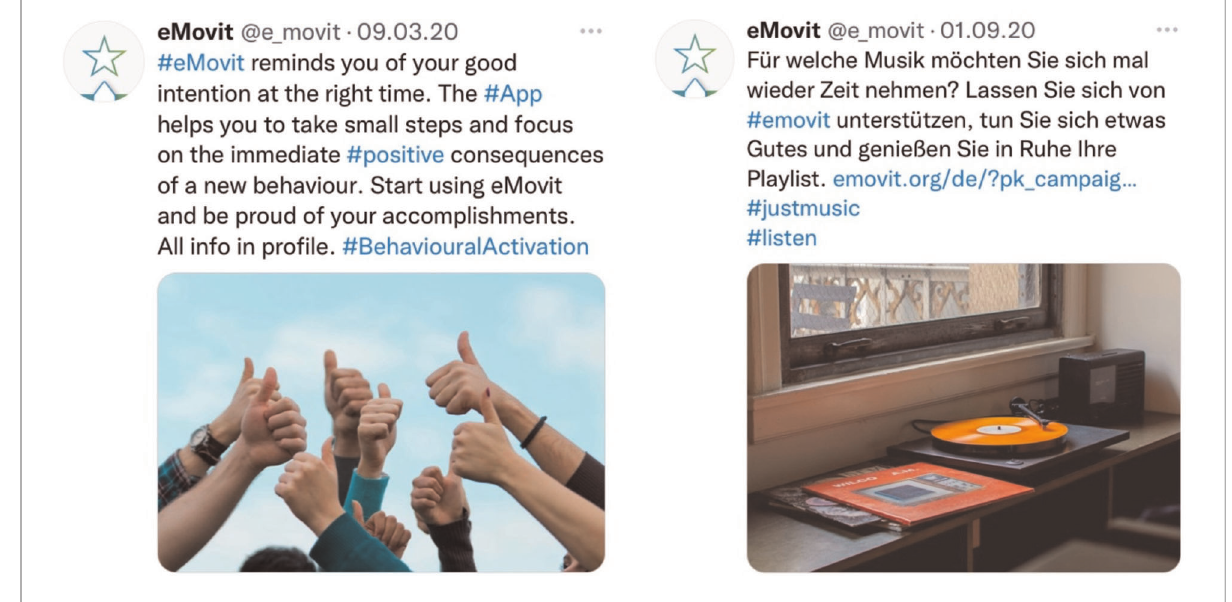
FIGURE 3 Examples of social media posts (Twitter) to disseminate eMovit.